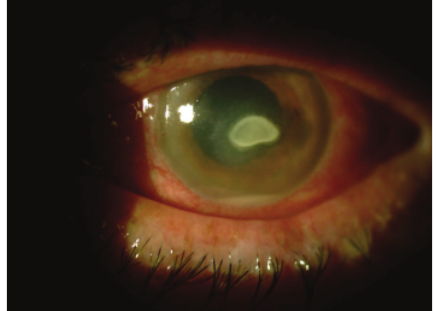
Figure 2: The right eye of the case 2 with paracentral corneal ulcer accompanying corneal stromal infiltration and